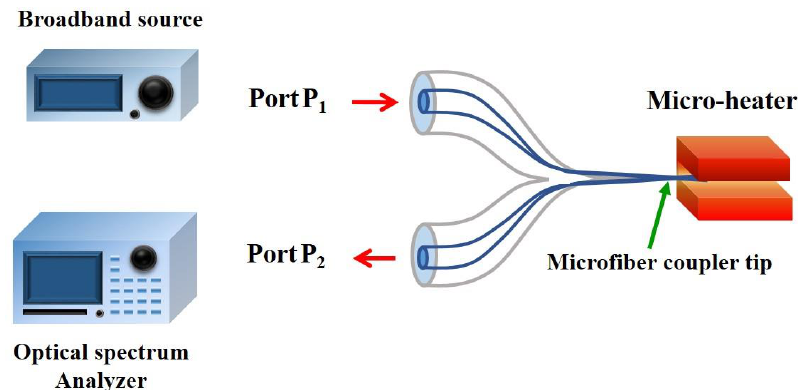
Figure 12. Experimental setup for temperature measurement using a bi-conical MF coupler tip